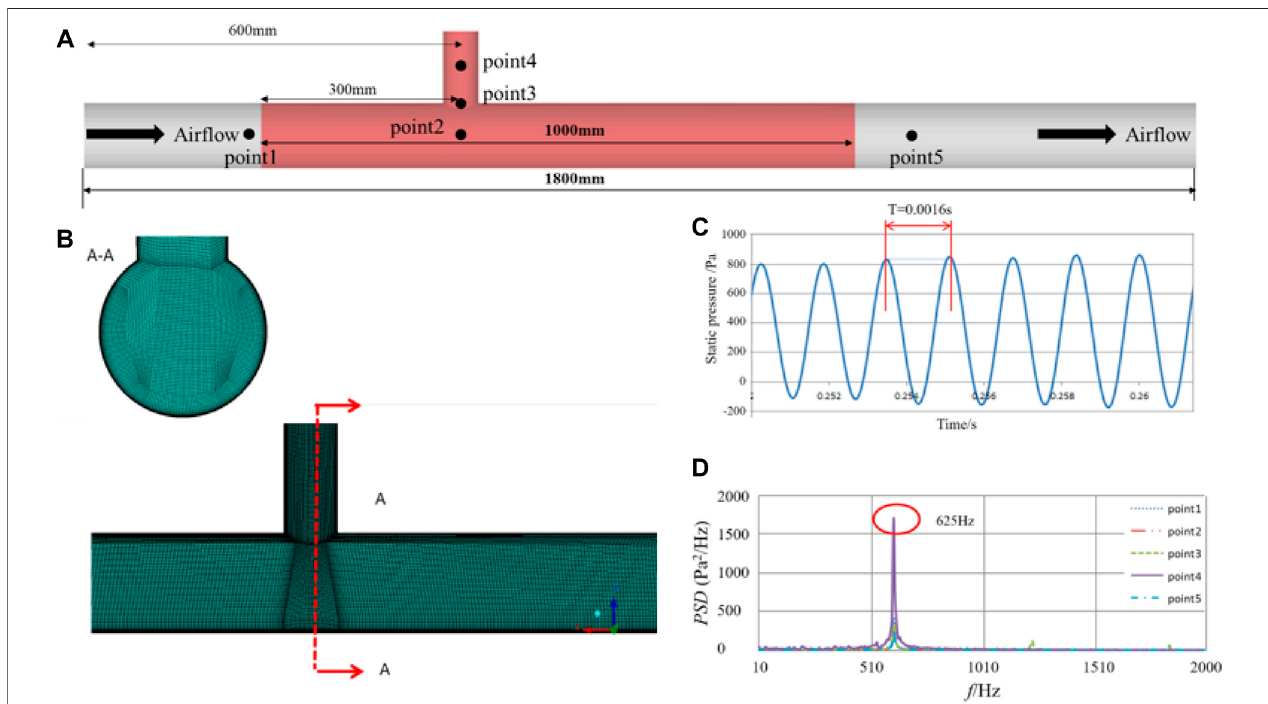
FIGURE1| Thestaticpressureovertimeanditspowerspectraldensity: (A) MonitorypointsofstaticpressureinCFDmodel; (B) middleplaneofCFDmesh; (C) the static pressure over time of point1; (D) the power spectral density of the fi ve points.